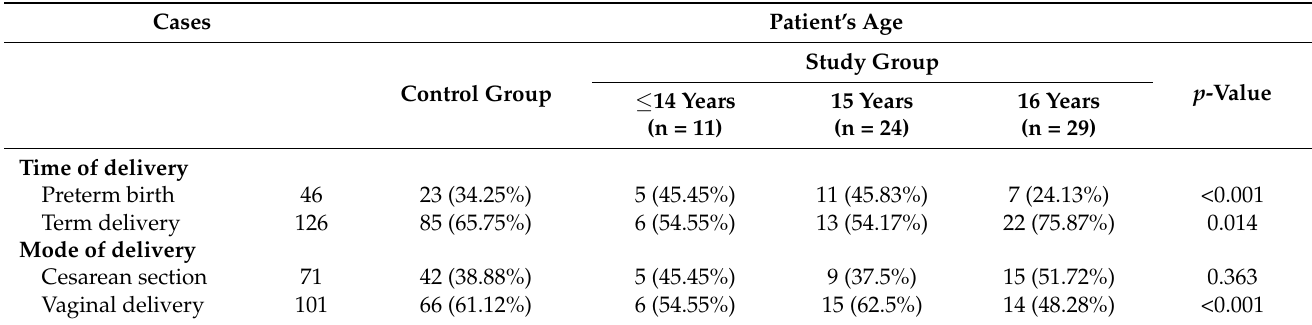
Table 4. Patients’ distribution in relation to time and mode of delivery according to maternal age.